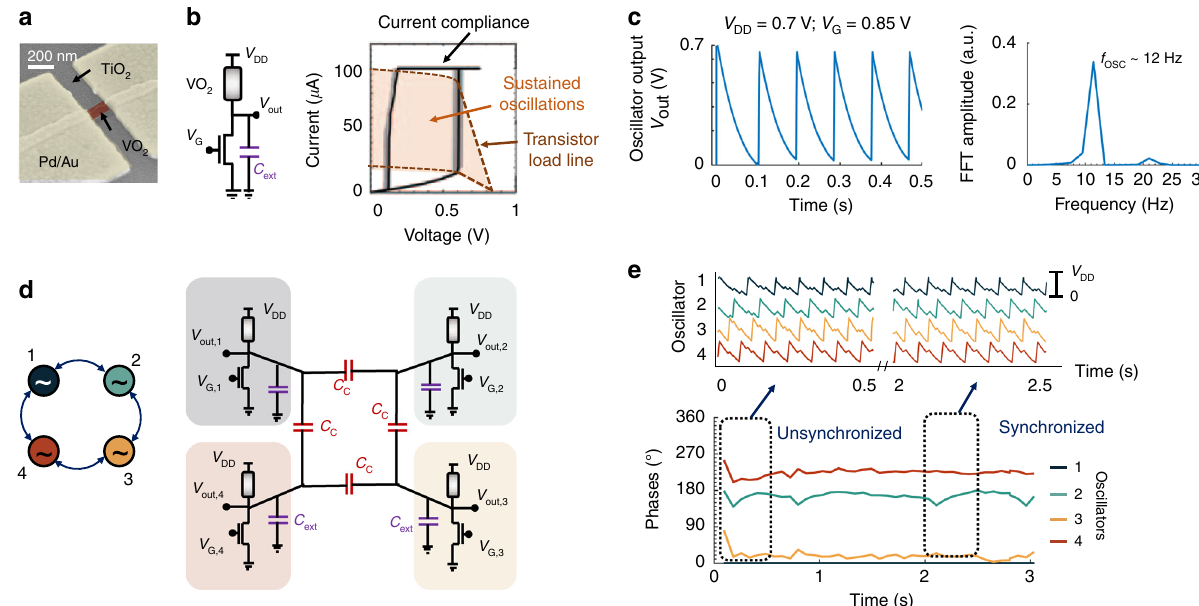
Fig. 2 a False-colored scanning electron microscope (SEM) micrograph of 200 nm size two-terminal VO 2 device. b , c Sustained oscillations are generated by connecting the VO 2 device in series with a MOSFET (metal – oxide – semiconductor fi eld-effect transistor) in a 1 Transistor-1 Resistor (1T-1R) con fi guration such that the FET load line intersects the vertical edges of the hysteresis loop of VO 2 at unstable points. d Schematic of a network of capacitively coupled oscillators used for generating phase patterns. e Experimentally measured spatiotemporal dynamics of the network. Starting from an initial unsynchronized condition, the oscillators rapidly undergo synchronization and a steady-state spatio-temporal phase pattern of the network emerges as the oscillators remain phase